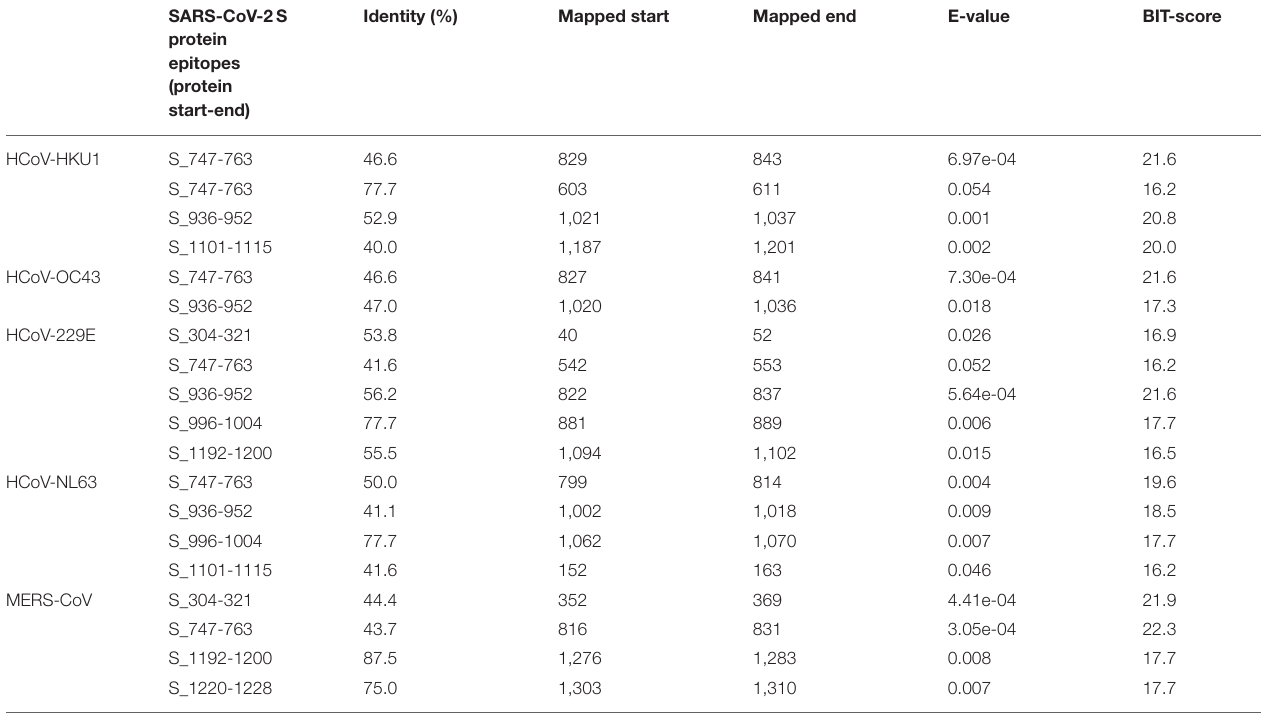
TABLE 4 | Sequence identity of S proteins of human alpha- and beta-coronaviruses against SARS-CoV-2-derived T-cell epitopes (evaluated by blastp program). SARS-CoV-2S protein